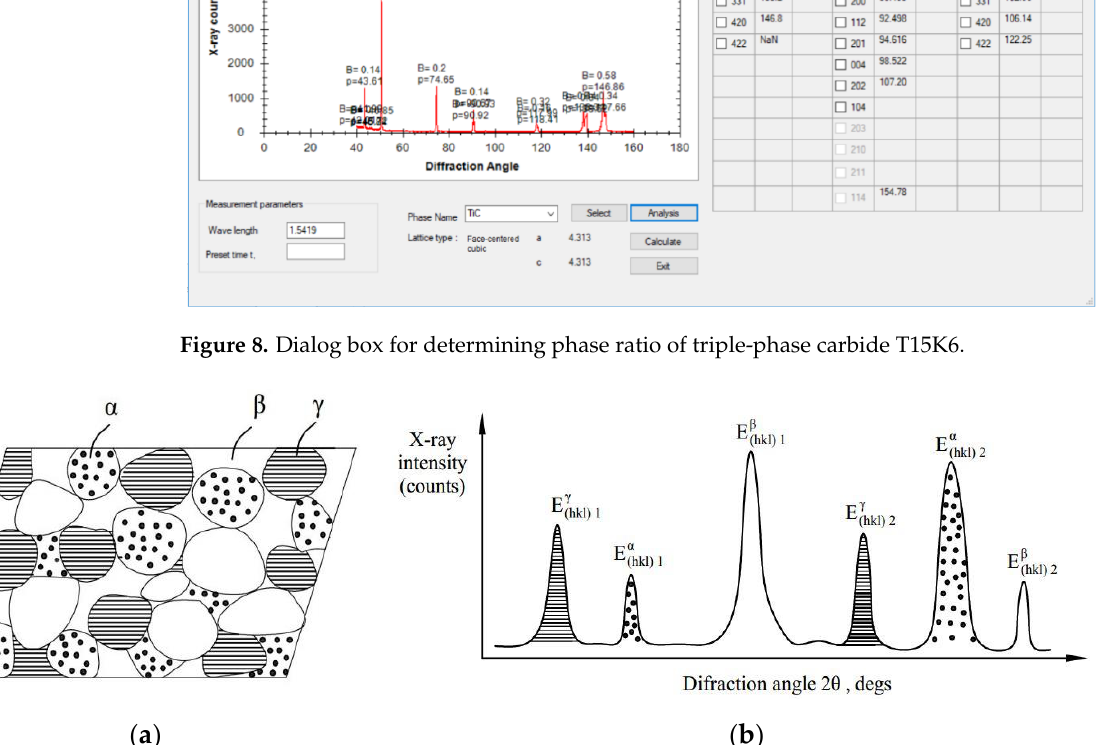
Table 3. XRD conditions for analyzing phase compositions of